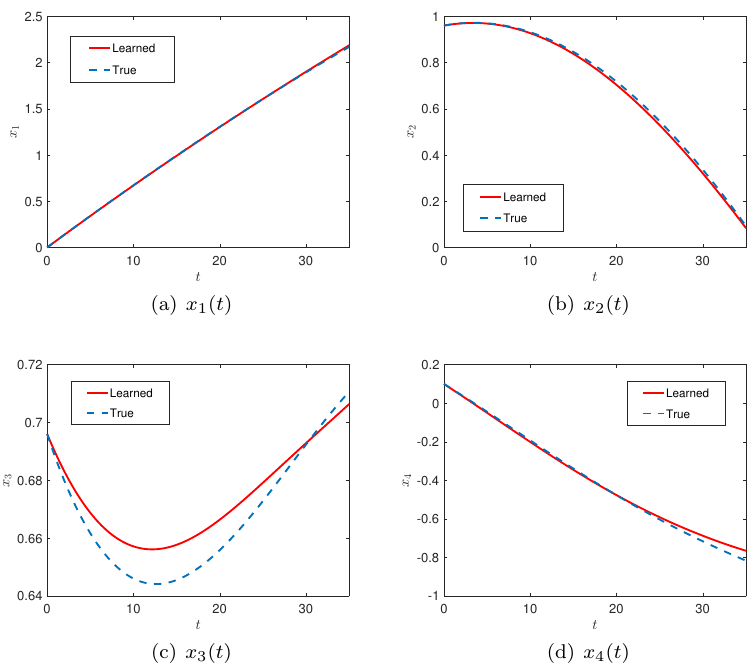
Fig. 2. Comparison between the trajectories of learned model (14) and true model (4) with noise. The components b 3 and b 4 do not depend on x 1 since the horizontal position of the missile does not affect its